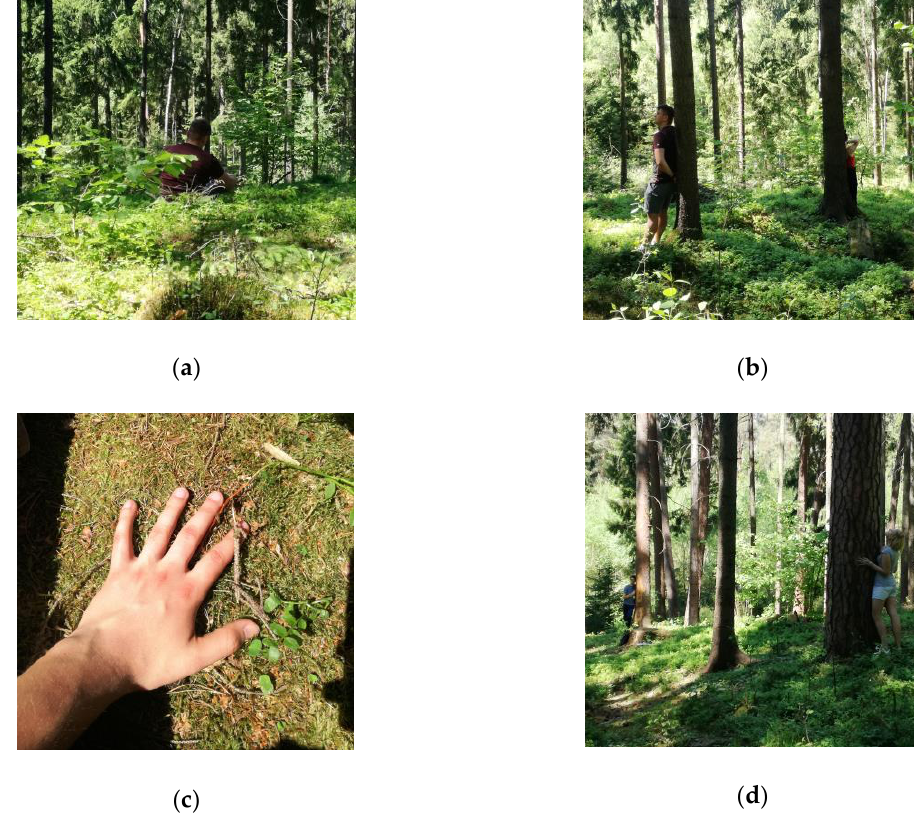
Figure 2. Activities undertaken during a forest recreation intervention: ( a ) Listening to the sounds of the forest; ( b ) viewing the forest; ( c ) touching forest items; ( d ) cuddling up to a tree. All photos provided by F. Ordon. Table 3. Schedule of the indoor (first day) and field (second day)